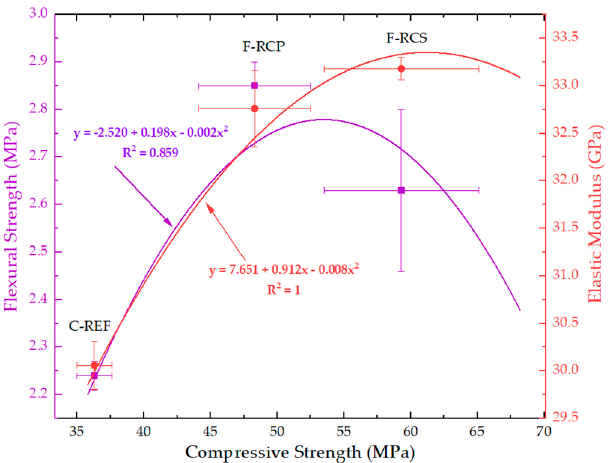
Figure 10. Correlation between compressive strength, the elastic modulus of concrete and flexural